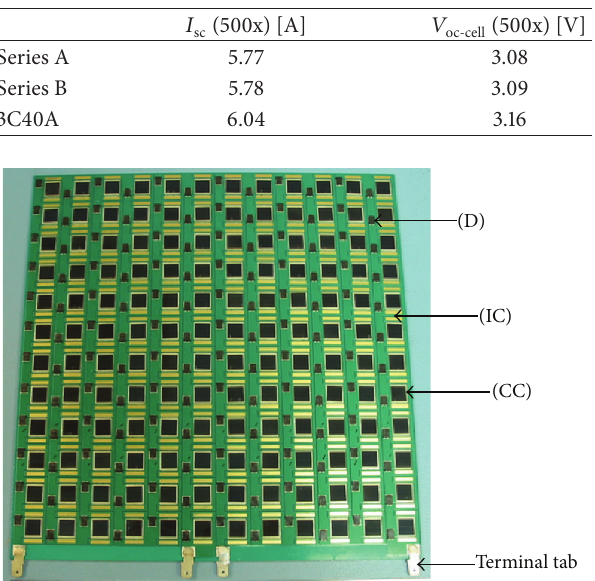
Figure 18: The cell assembly populated with cells (CC), intercon- nectors (IC), diodes (D), and terminal tabs.